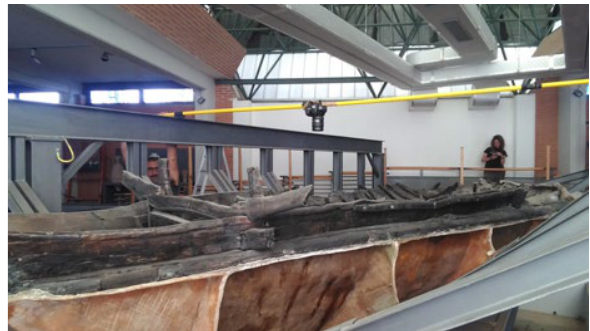
Figure 2. Digital camera (Nikon D750) bounded under a telescopic bar for zenithal photogrammetric survey.